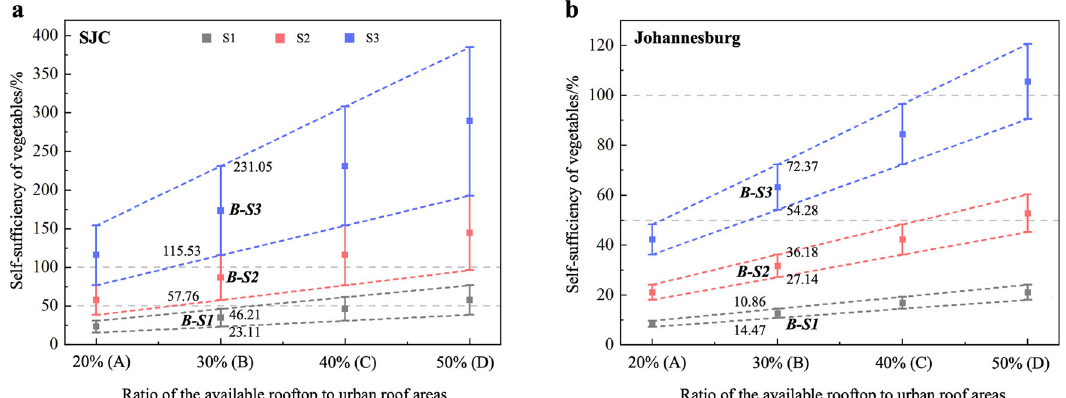
Fig. 5 Vegetable self-suf fi ciency of city-wide green roofs in different development scenarios. Panels ( a ) and ( b ) show the self-suf fi ciency of vegetables in SJC and Johannesburg, respectively. Taking Scenario B cluster in SJC ( a ), B-S1, B-S2, and B-S3 refer to 20%, 50%, and 100% of the city ’ s available roofs converted into green roofs, with the premise that 30% of urban building rooftops are available. Before the settings of scenarios, we assumed the urban rooftop areas (building footprints) as 5 – 10% of urban administrative areas in SJC (more details are available in Methods), resulting in the range of self-suf fi ciency of vegetables under each sub-scenario in Cluster